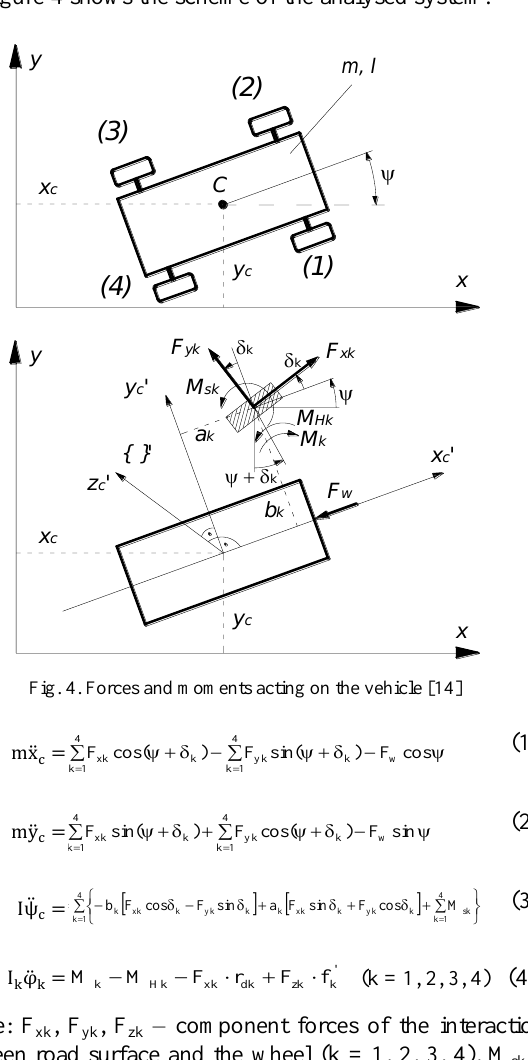
Fig. 5. Vehicle speed in speeding the vehicle straight ahead on a road with homogeneous high adhesion coefficient (ICE – internal combustion